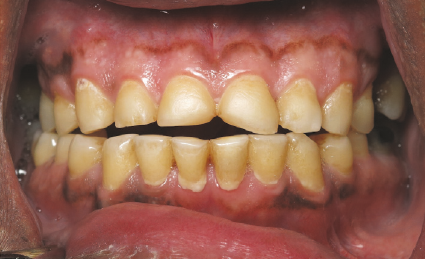
Figure 4: Protrusive interference and lack of anterior guidance.